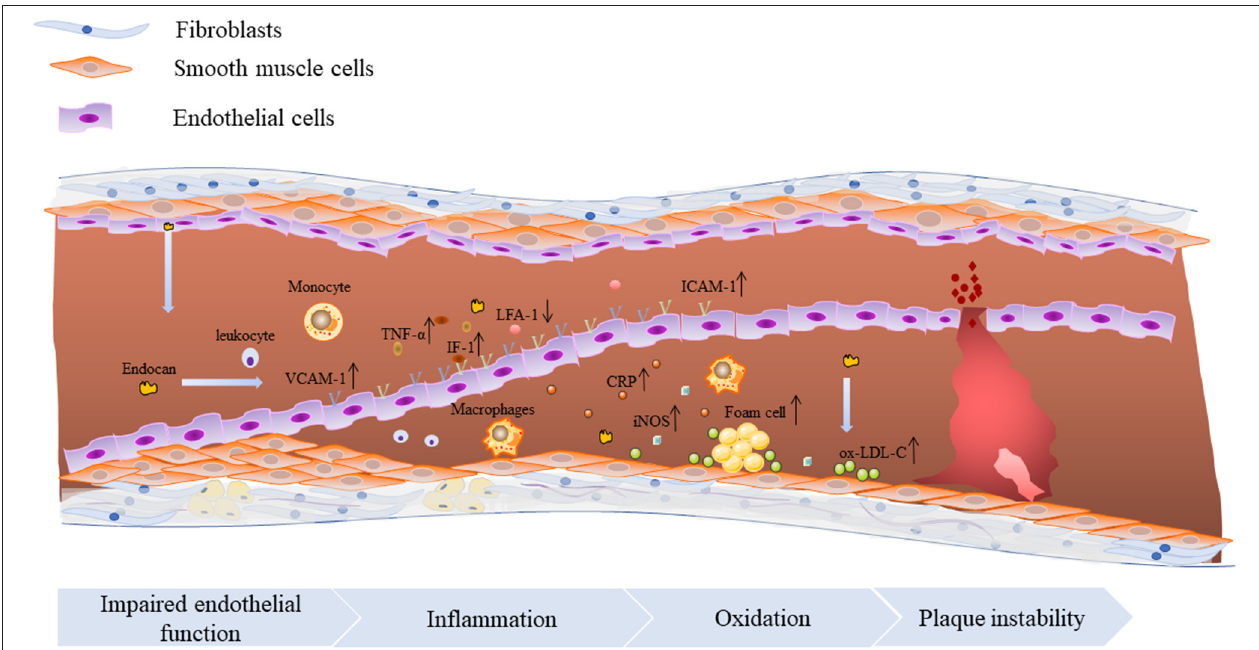
FIGURE 3 | The molecular mechanism of endocan promoting atherosclerosis. Endocan promotes the occurrence and development of atherosclerosis through a variety of ways, including promoting inflammation, leukocyte proliferation and migration, oxidative stress and foam cell